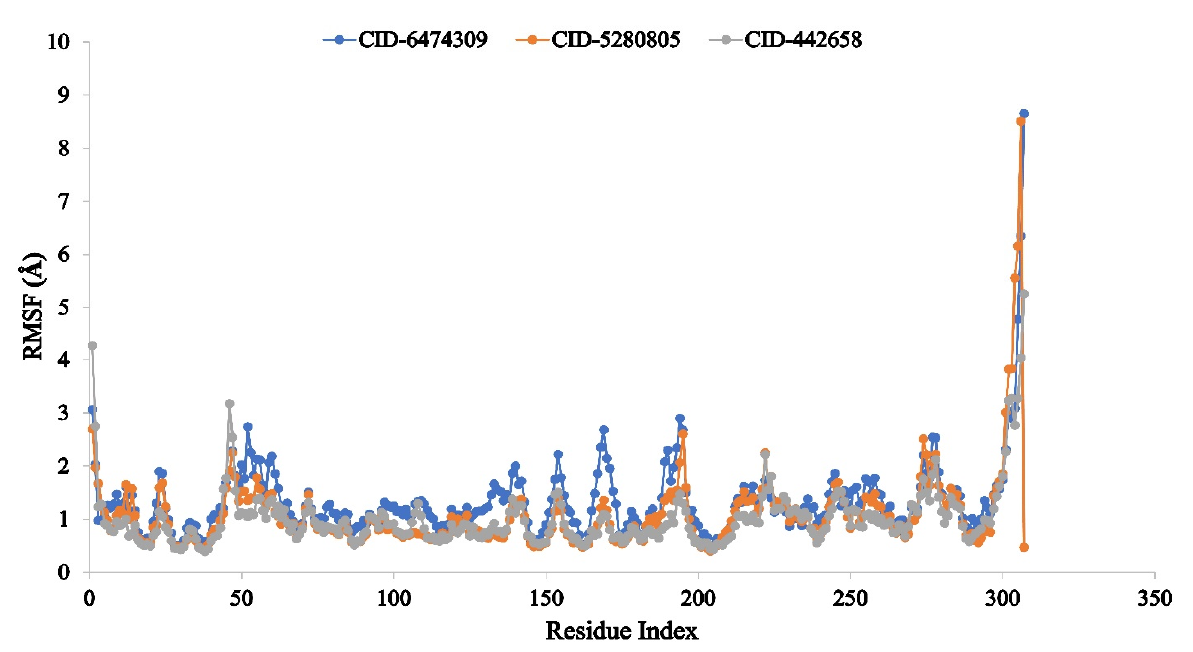
Figure 7. The RMSD values for the SARS-CoV-2 Mpro protein complexed with the three ligand compounds recovered from the complex system’s C α atoms. The selected three ligands compound 4,5-di- O -Caffeoylquinic acid (CID-6474309), rutin (CID-5280805), and schaftoside (CID-442658) in association with the selected protein are depicted by green, orange, and grey, respectively.